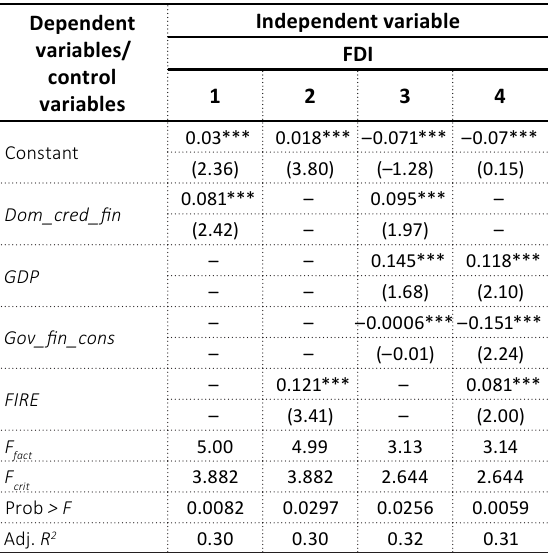
Table 7. Results of the identifying